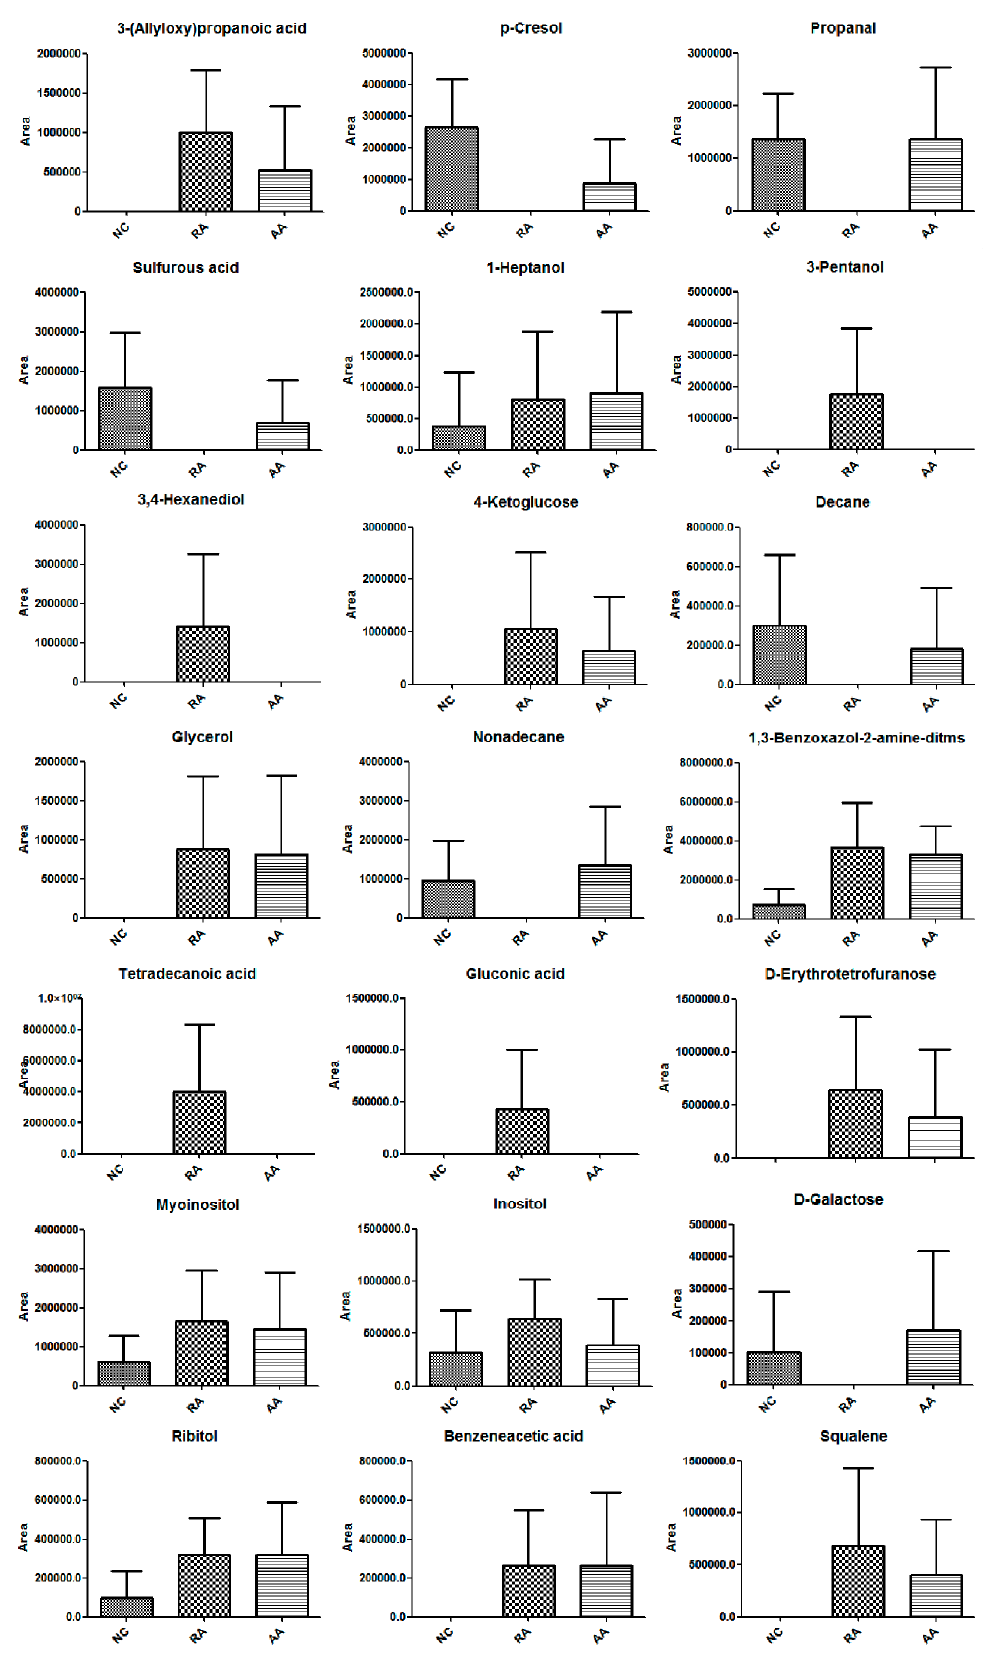
Figure 6. Areas of chromatographic peak of 21 biomarkers in NC, RA and AA groups.